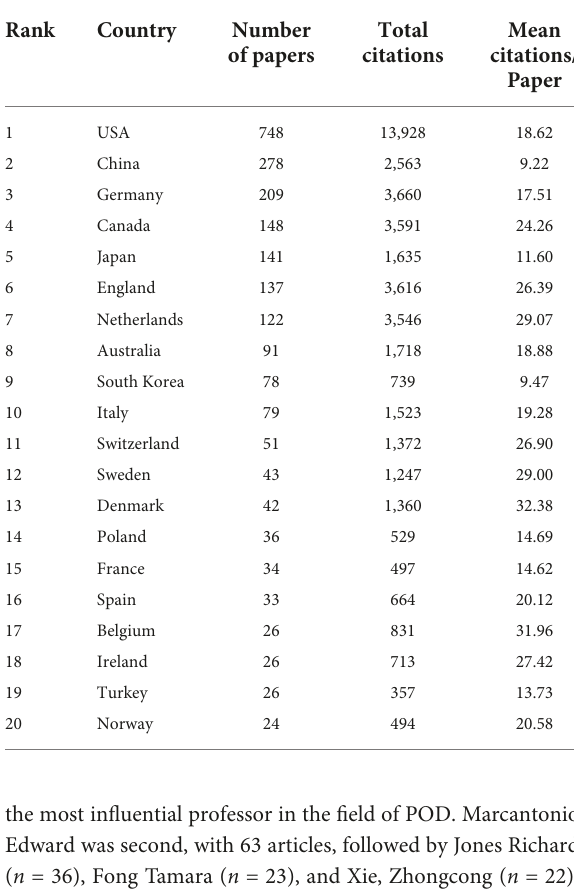
TABLE 1 The top 20 countries with the highest number of publications on postoperative delirium